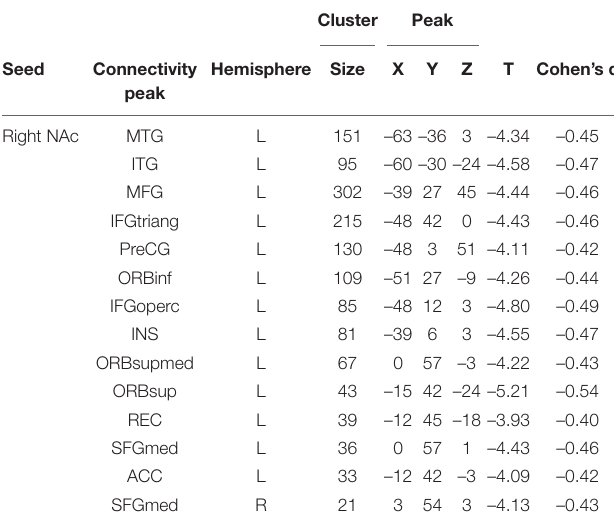
TABLE 3 | Dynamic Functional Connectivity (DFC) Group Comparisons (MDD vs. HCs).